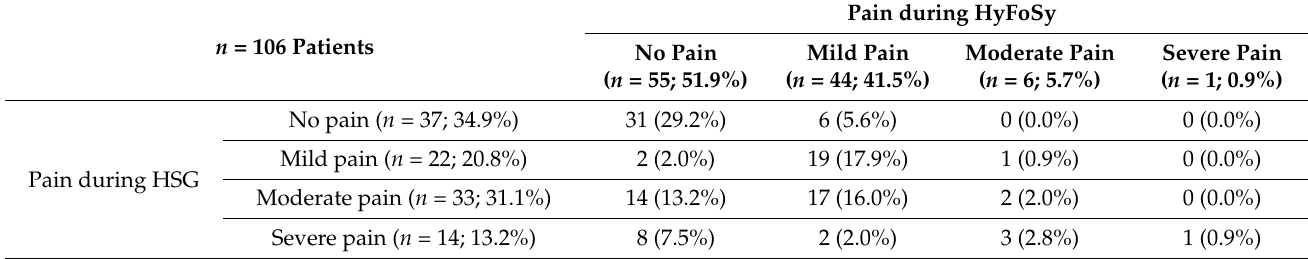
Table 3. Pain results.